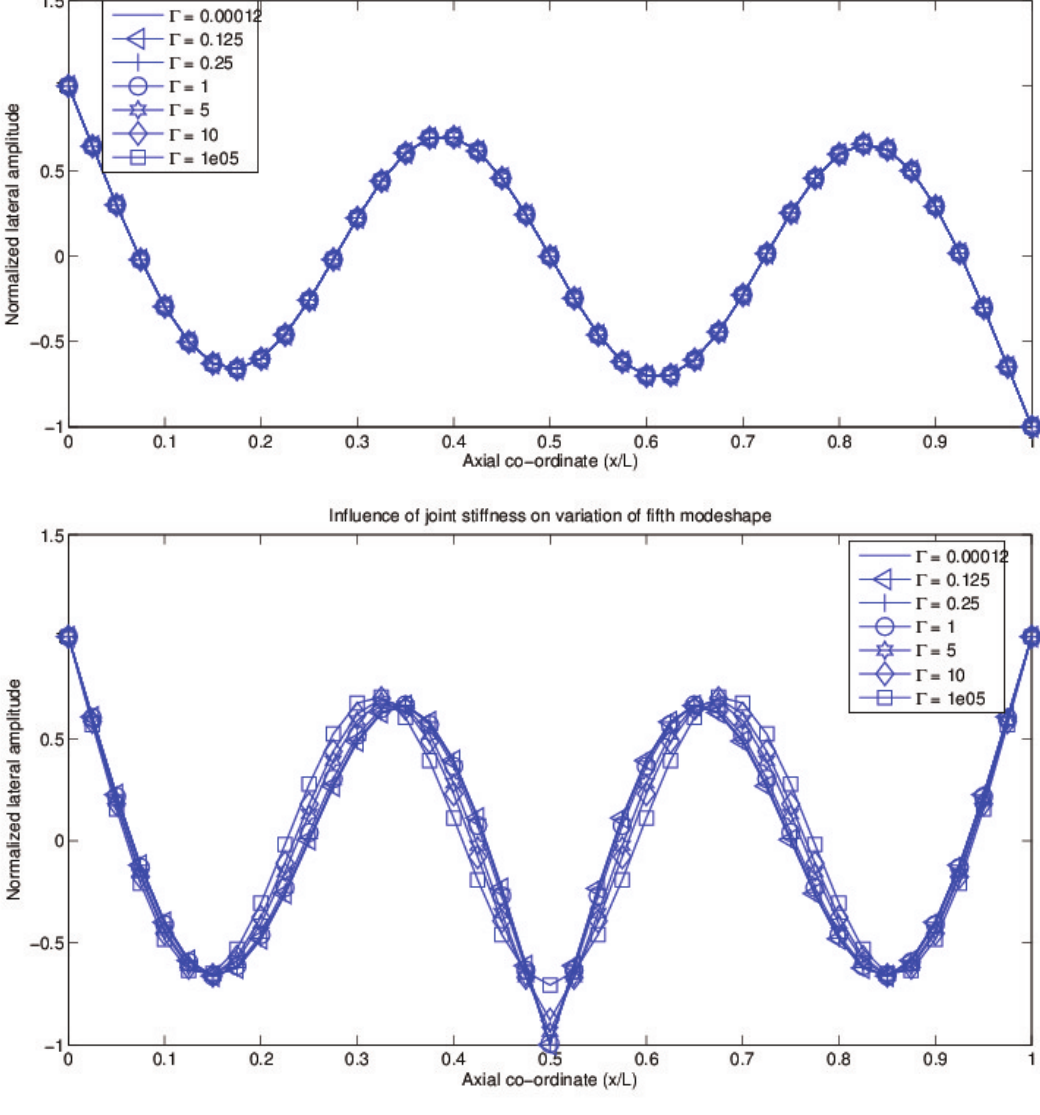
as loose (or hinged) joint. As the joint rotation stiffness ap- proaches to a very high value, the frequency of a free-free beam becomes insensitive to the variation in joint location across the beam. It is observed that the joint rotation stiff- ness and joint location parameters significantly influence the frequency variation of first five considered modes of a free-free beams. It is observed that, if a joint is situated at the nodal point of vibrating modeshape, the influence of joint stiffness on that mode of vibration becomes insignifi- cant and frequency and modeshape remains unchanged with variation in joint rotational stiffness. Influence of joint rotational stiffness on variation in first five mode-